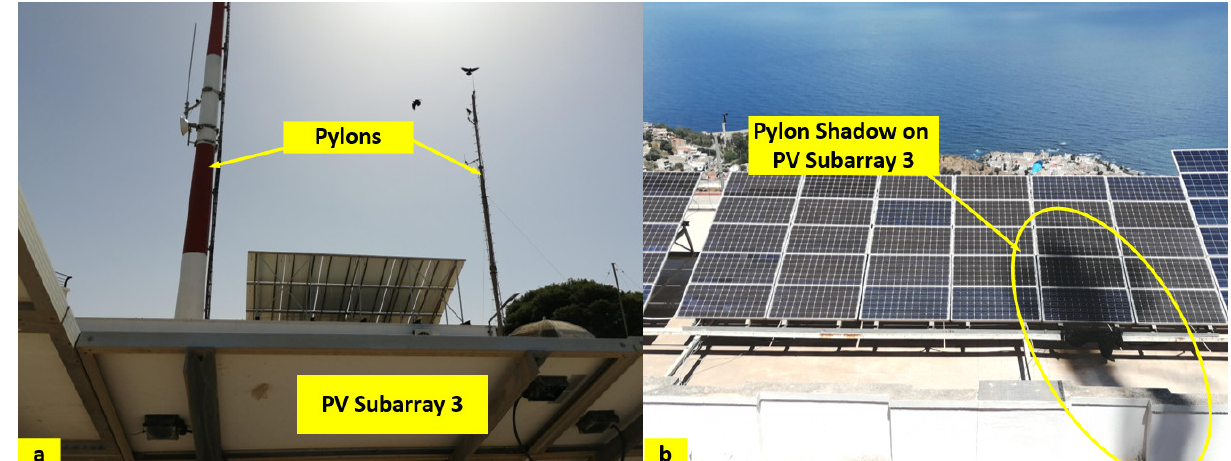
Figure 25. Photos of ( a ) pylons around PV sub-arrays and ( b ) shading on the PV sub-array 3.